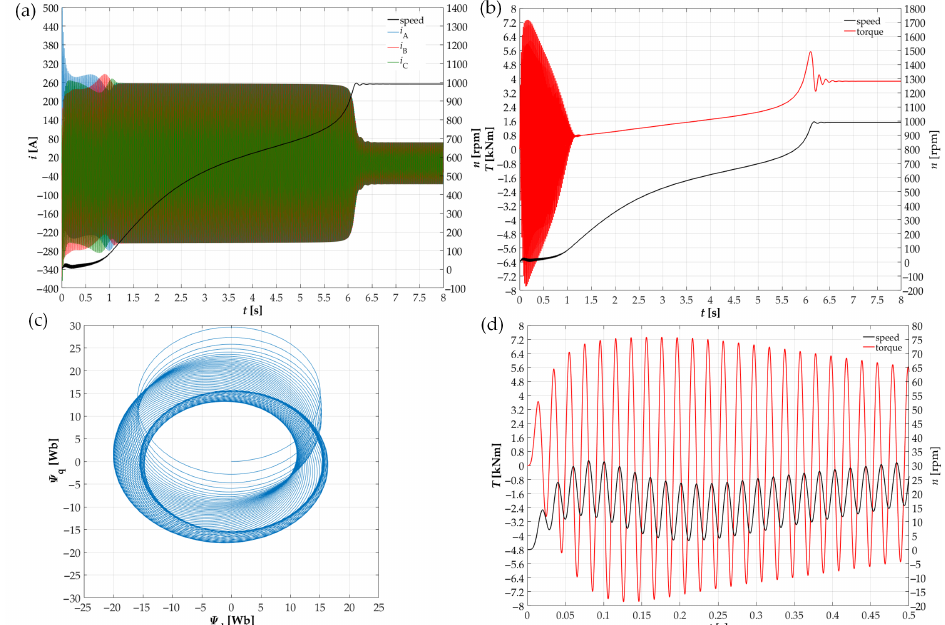
Figure 11. Waveforms of physical quantities for direct starting, with no voltage phase delay and (cid:1) 2 (cid:0) n fan load moment T o = 3859 : ( a ) time waveforms of stator current in three phases and rota- 990 tional speed; ( b ) electromagnetic torque and rotational speed timing; ( c ) hodograph of stator fluxes; ( d ) electromagnetic torque and rotational speed timing diagram, in the first moment of starting.